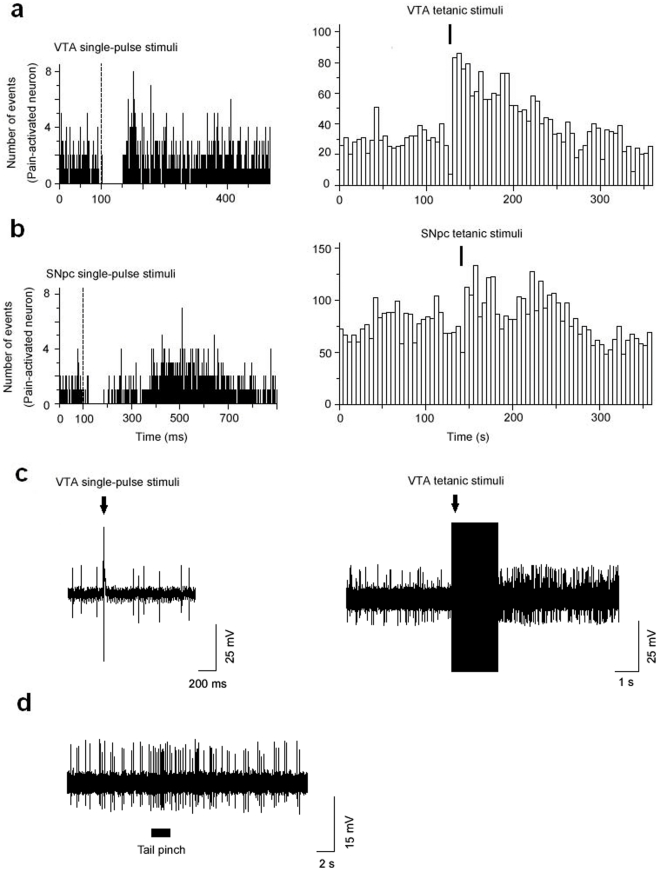
Effects of single-pulse stimulations of the VTA and the SNpc on the LHb PA neurons.The recordings of panels a, b and c are from different neurons. (a, b, c left panels) The LHb PA neurons generally exhibited a similar transient cessation in firing in response to the single-pulse VTA stimulation and the single-pulse SNpc stimulation. The left panel c showed an original firing recording for the LHb PA neuron's response to single-pulse stimulations of the VTA. Both the peristimulus time histograms were comprised of 100 consecutive sweeps. Each single stimulus pulse was delivered 100 ms after the onset of each sweep (bin: 1 ms; a, b left panels). (a, b, c right panels) PA neuron firing was increased by the tetanic VTA stimulus and the tetanic SNpc stimulus. The right panel c showed an original firing recording for the LHb PA neuron's response to the tetanic VTA stimulus. Both histograms displayed using a bin of 5 s (a, b right panels). (d) an original firing recording for the LHb PA neuron's response to tail pinch.